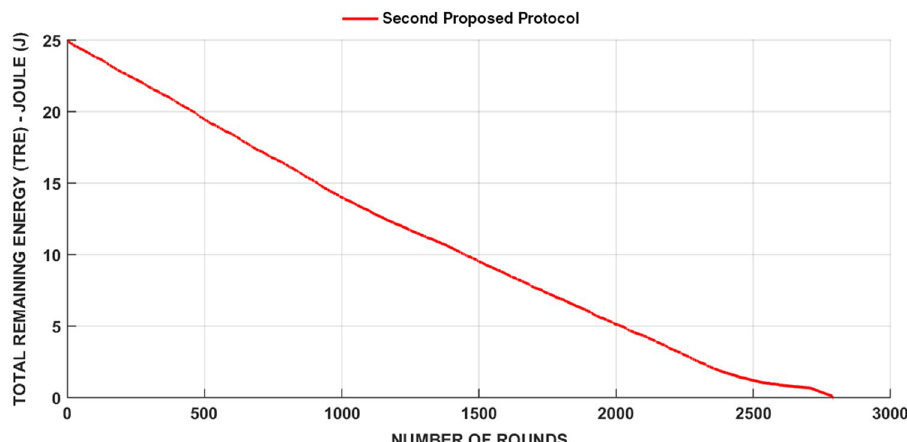
Fig. 16 Total remaining energy in relation to the number of rounds in scenario 3, the sec- ond proposed protocol